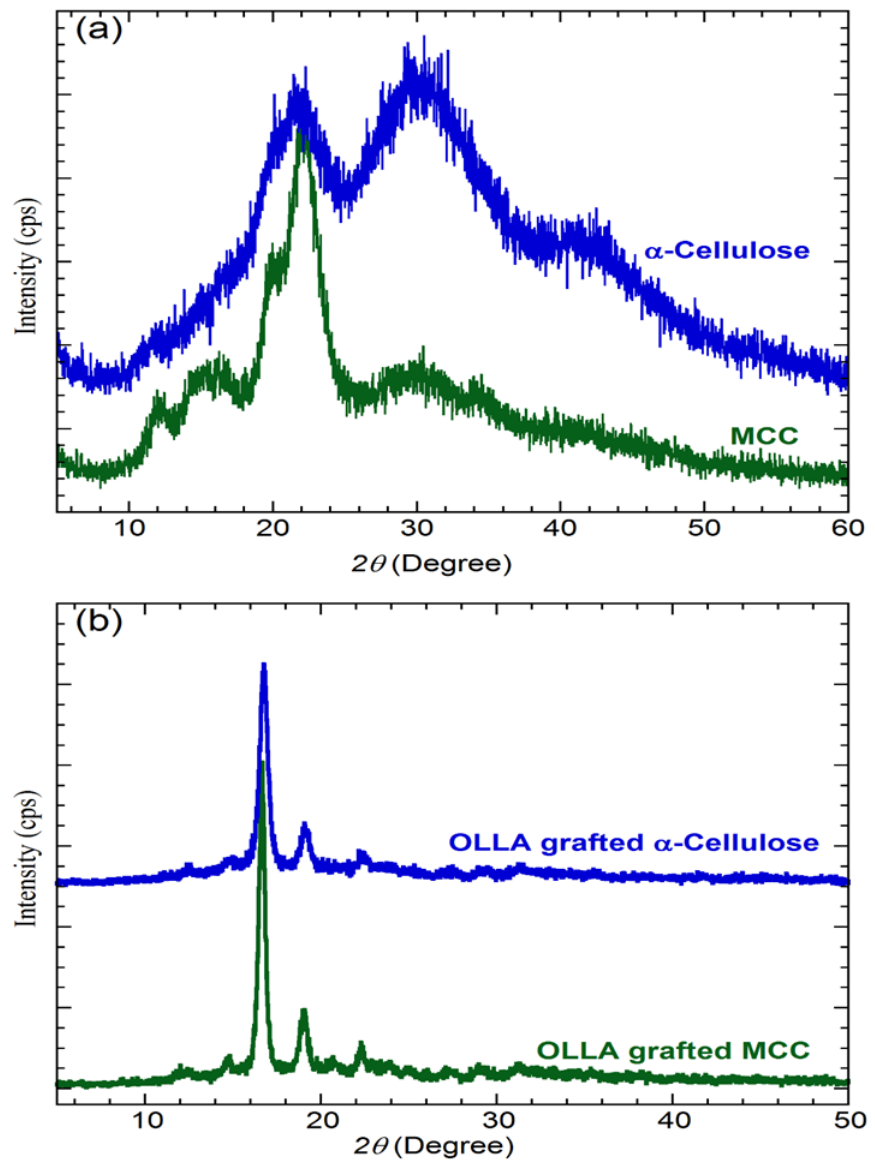
Figure 6. WAXS spectra of α -cellulose and MCC: non-grafted ( a ), and grafted ( b ). The crystallinity in α -cellulose, MCC, grafted α -cellulose, and grafted MCC were calculated to 27.1%, 39.5%, 46.7% and 60.6%, respectively. The crystallinity of PLLA was reported to 47.6% by Dai et al. (2020) [53]. It is suggested here that the crystallinity of MCC is higher than that of α -cellulose. Grafted α -cellulose and MCC show sharp peaks at 16.7 ◦ and 19.0 ◦ and small peaks at 22.4 ◦ . Peaks at 16.7 ◦ and 19.0 ◦ were caused by the homo crystalline structure of pseudo-orthorhombic unit cell with dimensions of a = 1.07 nm, b = 0.595 nm and c = 2.78 nm containing 10 3 helical structures. These two characteristic peaks are similar to what has been reported for PLLA homo crystallinity [54]. This also supports the grafting of OLLA on the surface of cellulose and MCC.